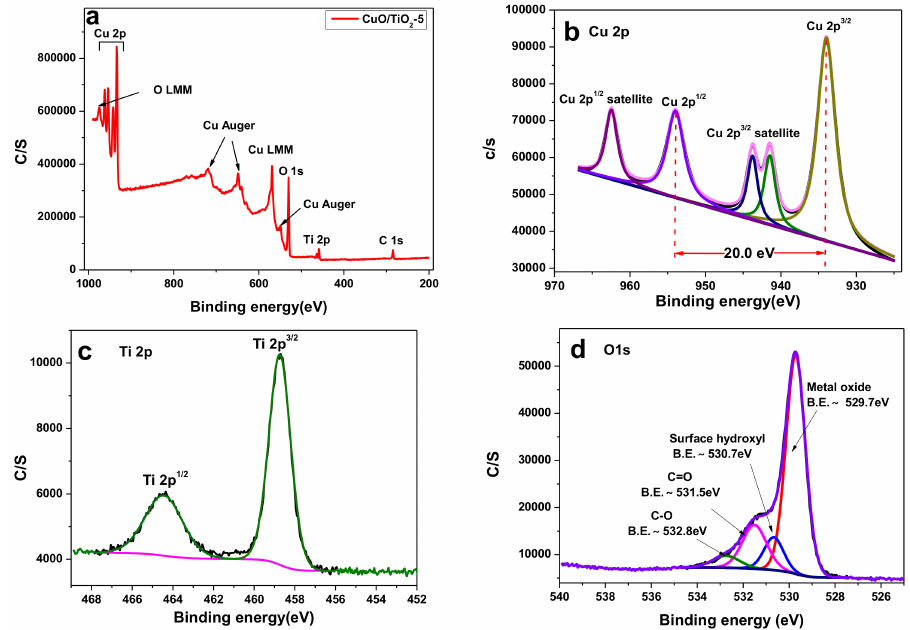
Figure 2. ( a ) The full XPS spectrum of CuO/TiO 2 -5 catalyst and high-resolution XPS spectra of ( b ) Cu 2p; ( c ) Ti 2p and ( d ) O 1